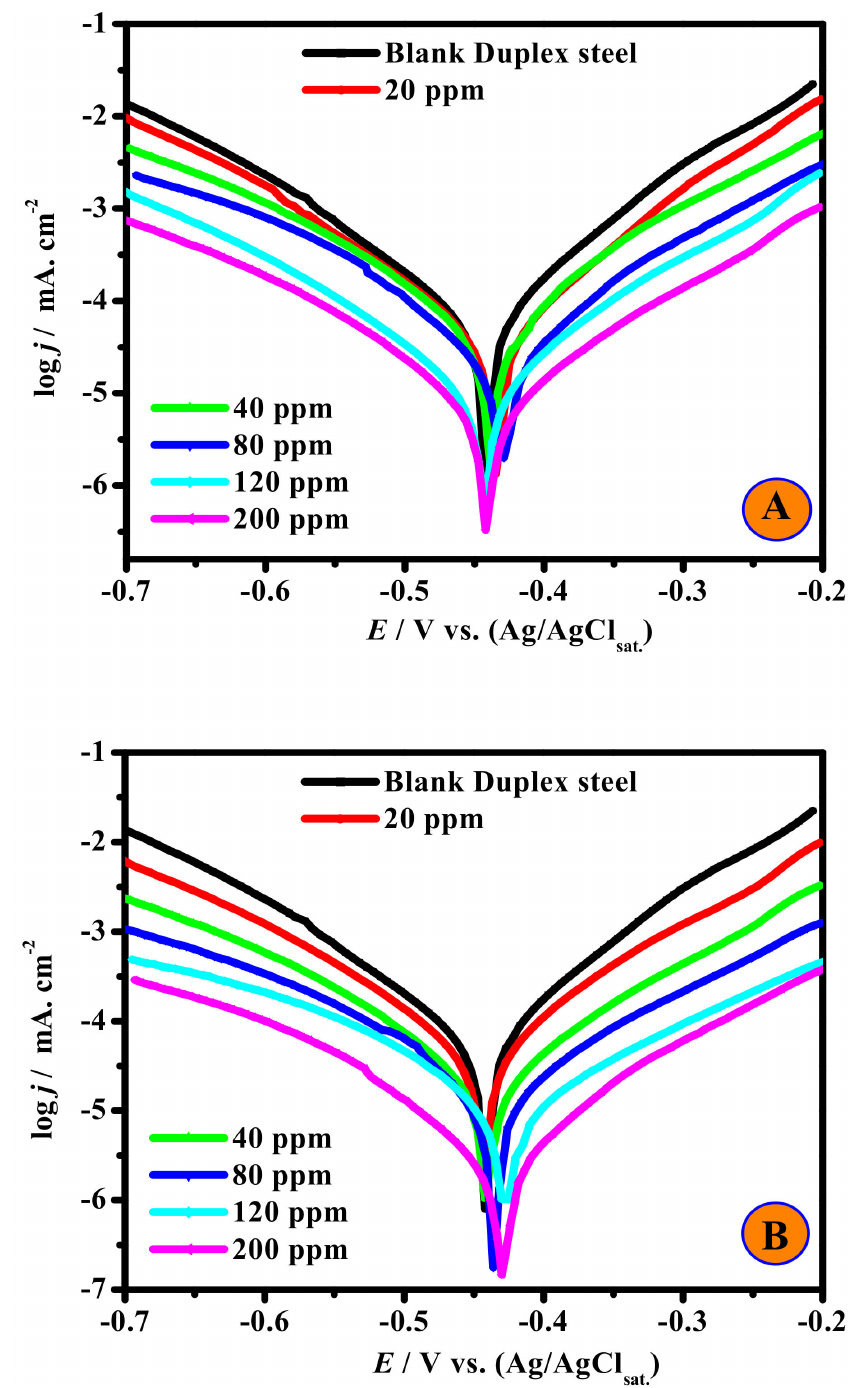
Figure 6. Tafel profiles for duplex steel at 323 K in 2.0 M H 2 SO 4 without and with various concentra- tions of ( A ) CH and ( B ) CH/Zn@H 3